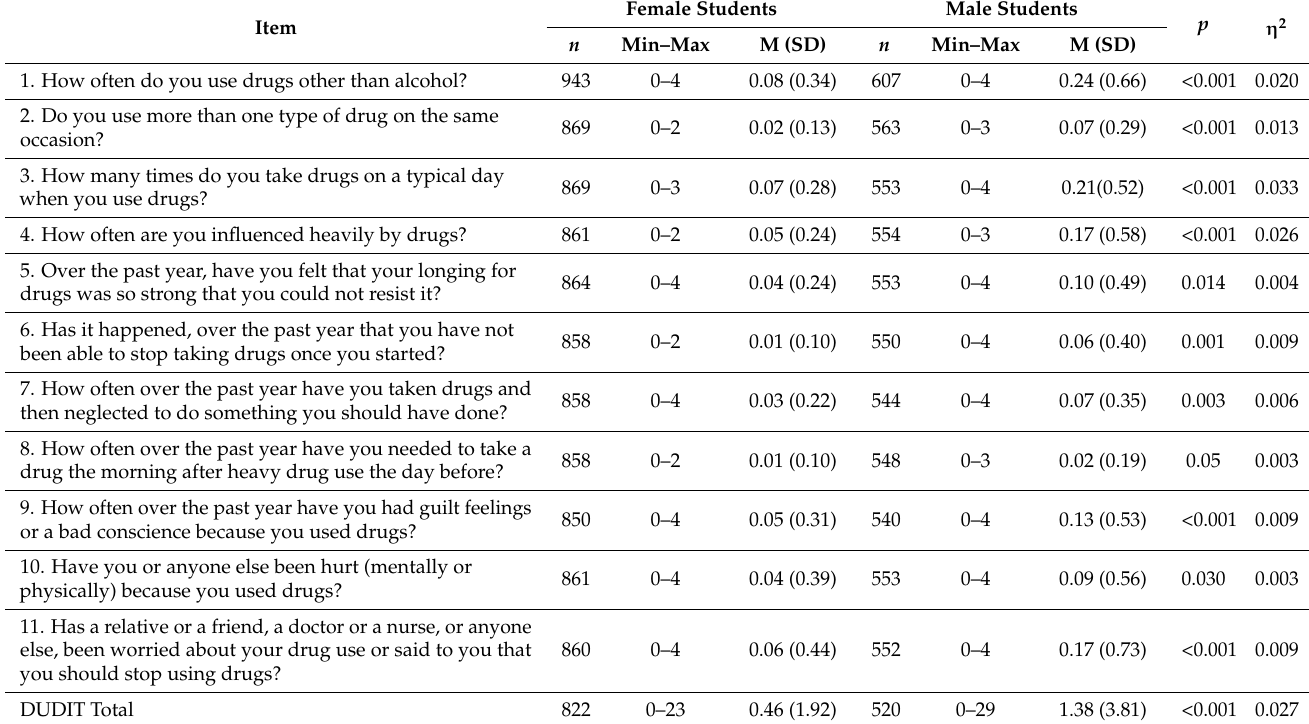
SD = 0.86, n = 848) with a small effect size ( p < 0.001, η 2 = 0.030). The drug-related problems factor (factor 2) also revealed a significant difference between males (M = 0.65, SD = 2.45, n = 529) and females (M = 0.24, SD = 1.25, n = 834), but hardly reached a small effect size ( p < 0.001, η 2 = 0.010). Male participants scored significantly higher (indicating a higher frequency of that behavior) than their female classmates for each item in the DUDIT except item 8 (“How often over the past year have you needed to take a drug the morning after heavy drug use the day before?”), for which the difference was very close to significant ( p = 0.05; Table 3). The effect size of the difference was small for the first four items and negligible for the rest of the items. Table 3. Comparison of scores on each DUDIT item and total DUDIT scores between male and female high school students. Female Students Male Students p η 2 Item n Min–Max M (SD) n Min–Max M (SD)